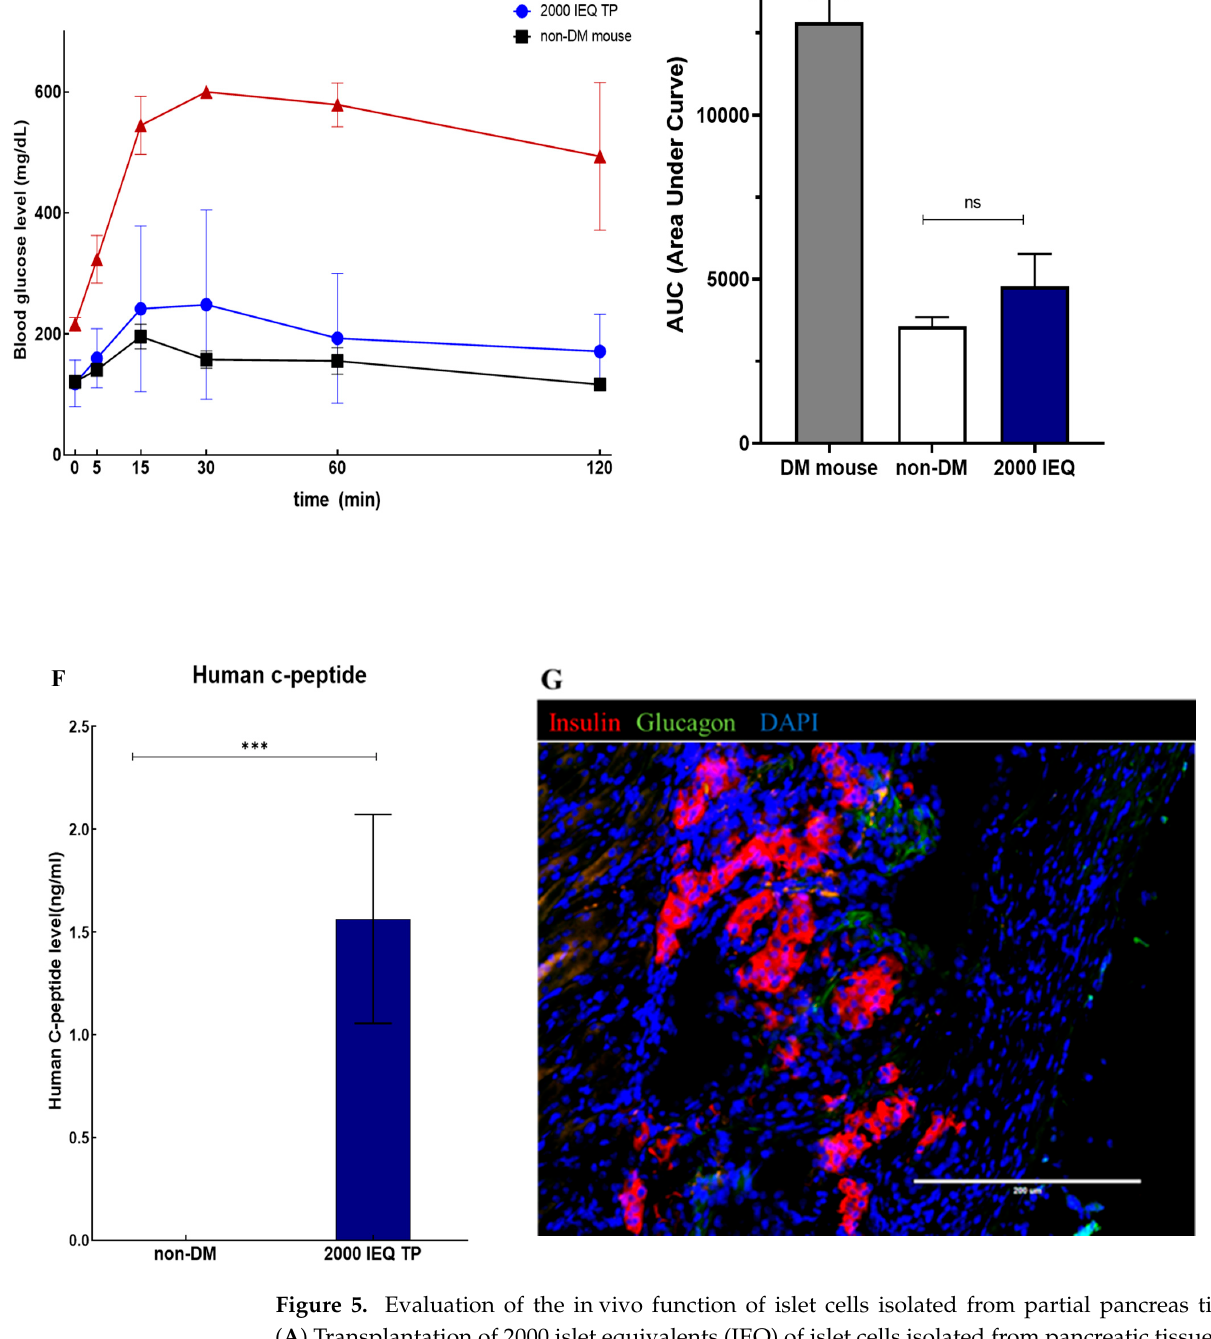
Figure 5. Evaluation of the in vivo function of islet cells isolated from partial pancreas tissue. ( A ) Transplantation of 2000 islet equivalents (IEQ) of islet cells isolated from pancreatic tissue into the kidney membrane of diabetic mice. Arrow, islet cell transplanted into the kidney membrane. Observations of changes in ( B ) blood glucose levels and ( C ) body weight ( n = 8). ( D ) Intraperitoneal glucose tolerance test ( n = 9). ( E ) Area under the curve based on an intraperitoneal glucose tolerance test (IPGTT) ( n = 9) *** p < 0.0001, ns (Not significant) ( F ) Human c-peptide levels 90 days after islet cell transplantation ( n = 3). ( G ) Immunofluorescence staining of the expression of glucagon and insulin 40 d after islet kidney transplantation. (Scale bar: 200 µ m) *** p <